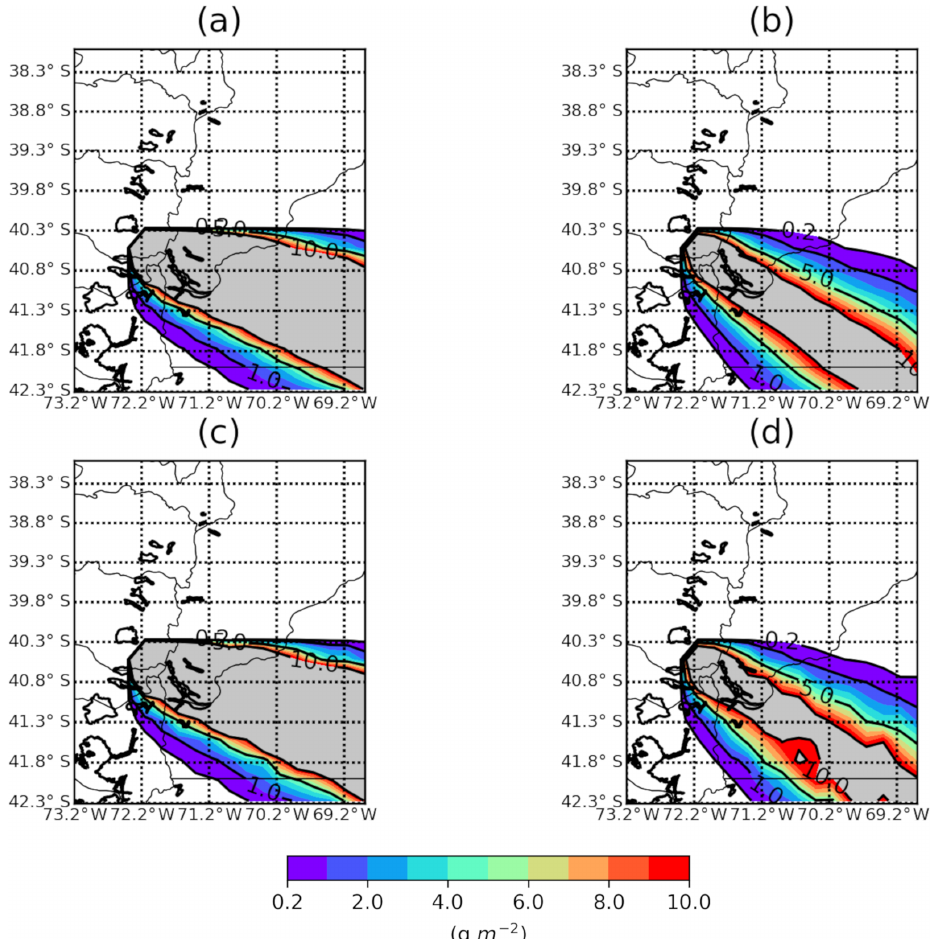
Figure 5. Ash mass loading on 7 June at 12:00UTC for (a) the nature run with constant parameters, (c) the run with observational error and constant parameters, the (b) nature run with time-dependent parameters, and (d) the run with observational error and time-dependent parameters. Ash mass loading values outside the 0.2–10.0gm − 2 interval are in